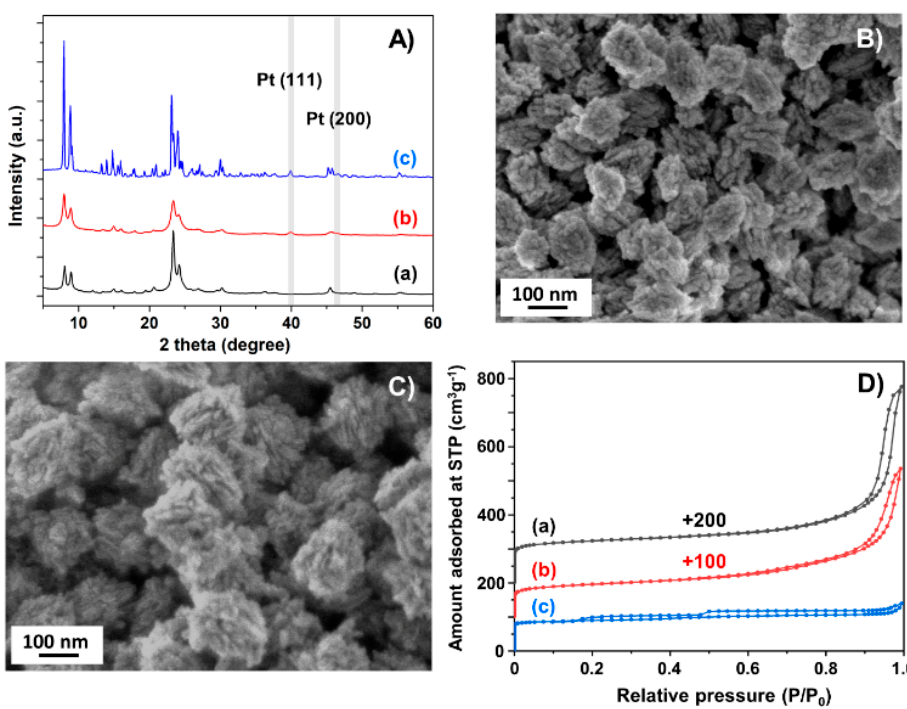
Figure 1. ( A ) X-ray diffraction (XRD) patterns of (a) Pt@SiNS(one), (b) Pt/SiNS(imp), and (c) Pt/SiCON(imp), scanning electron micrograph (SEM) images of ( B ) Pt@SiNS(one) and ( C ) Pt/SiNS(imp), and ( D ) N 2 adsorption/desorption isotherms of (a) Pt@SiNS(one), (b) Pt/SiNS(imp), and (c) Pt/SiCON(imp).